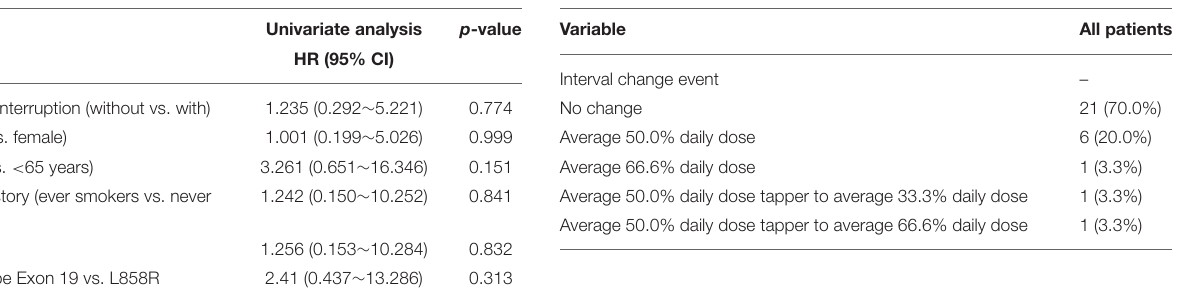
TABLE 2 | Risk factors of disease-free survival.